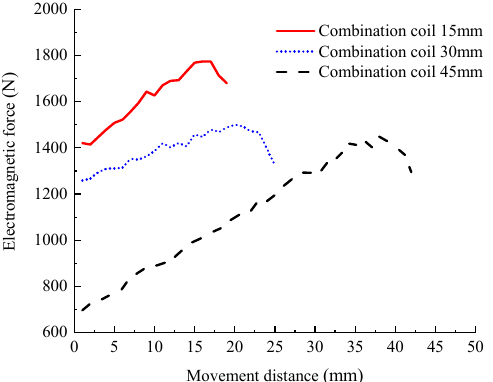
Figure 14. Comparison of steady state electromagnetic forces of combined coils with different lengths.